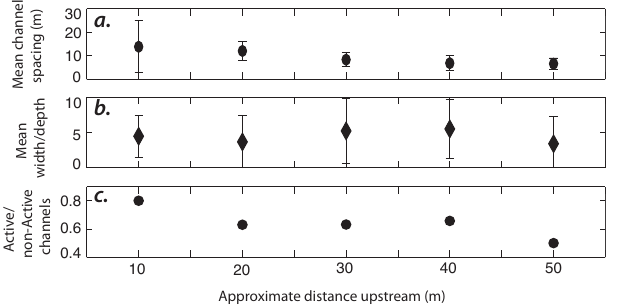
Fig. 3. Network characteristics of the Llewellyn drainage basin shown in Fig. 2b, higher numbers moving upstream. (a) Mean chan- nel spacing (inverse of channel density) with standard deviation er- ror bars (b) . Mean width to depth of active channels, with standard deviation. (c) . Ratio of active to non-active (abandoned)